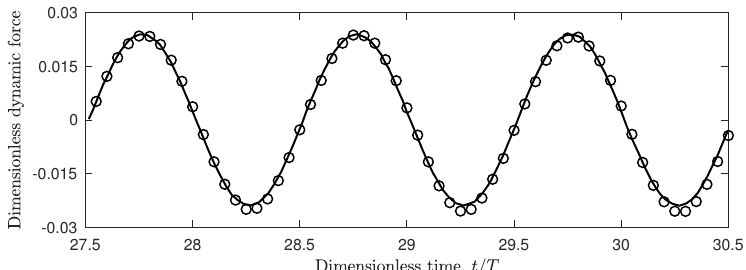
Figure 5. Time history of dynamic wave force acting on the bottom of the obstacle. Line: model predictions. Symbol: numerical results [26]. Time is normalized by the wave period T . Wave force is normalized by the hydrostatic force at the obstacle bottom. Parameters are the same as those used in Figure